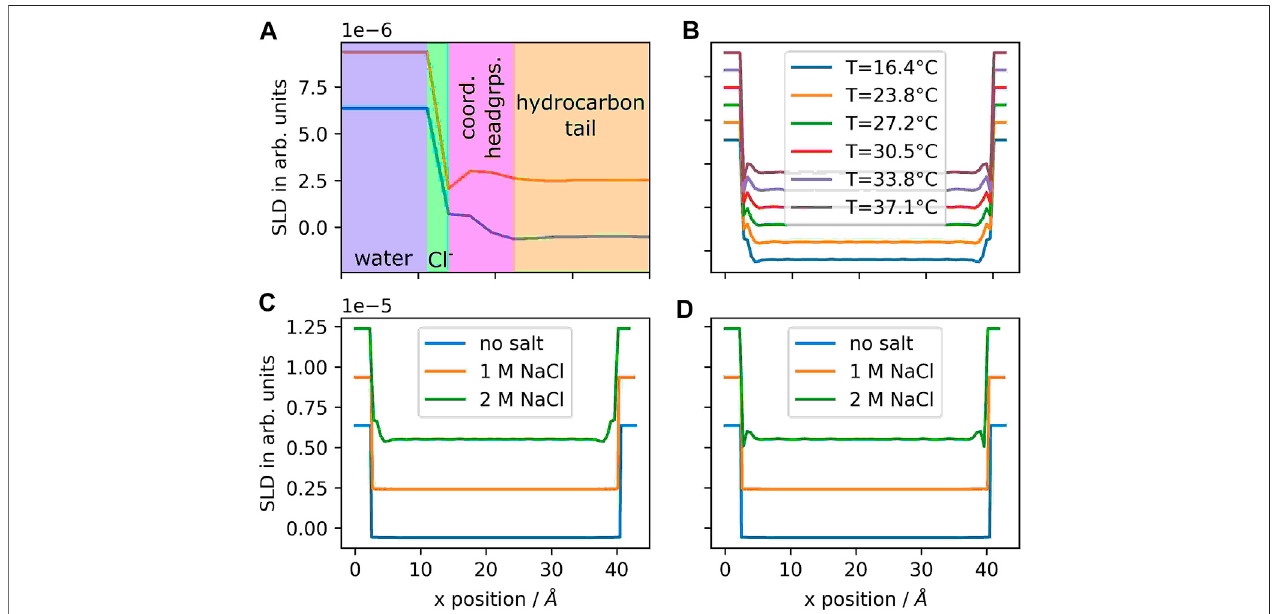
FIGURE6| SLD pro fi lesdeterminedfromre fl ectometrydataviainverse FFTanalysis; (A) :2 M,lowest andhighest temperature zoom-in. Thewaterarea(D 2 OSLD (cid:1) 6.3 10 − 6 Å − 2 ) is shaded blue, the area where chlorine ions are enriched is shaded green, the area where sodium ions interact with the phospholipid head groups, causingatemperaturedependentcoordinationisshadedmagentaandtheareaofthehydrocarbontail(C 10 H 22 SLD (cid:1)− 0.49 · 10 − 6 Å − 2 ); (B) :2 Malltemperatures, (C) :all concentrations 1 and 2 M at 16.4 ° C, salt-free at 37 ° C; (D) : all concentrations 1 and 2 M at 37.1 ° C, salt-free at 37 ° C. Upper limit in all cases is 6.3 10 − 6 Å − 2 for D 2 O and − 0.49 10 − 6 Å − 2 for the pure hydrocarbon tails of the phospholipids. Curves are shifted against each other for better visibility.